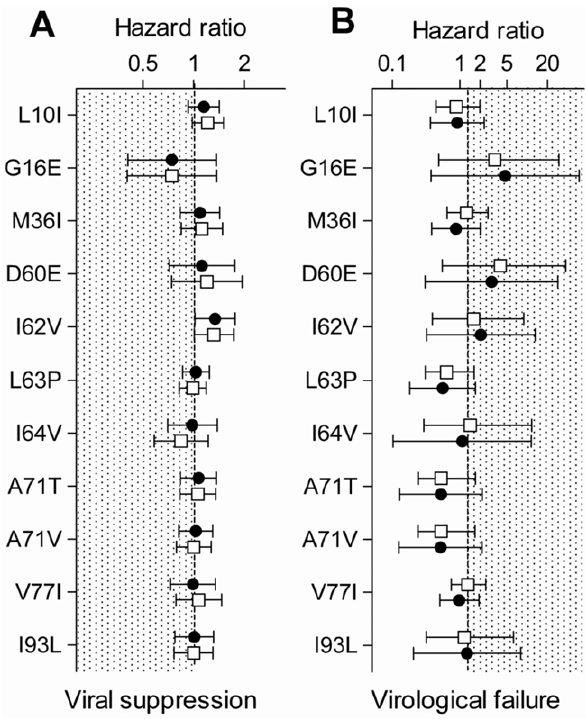
Figure 3. Cox regression models. Univariable (solid circles) and multivariable (open squares) Cox regression models comparing (A) time to viral suppression and (B) time to virological failure. 95% confidence intervals are indicated. The treatment outcome is worse in the presence of minor protease inhibitor mutations if the hazard ratios lie in the shaded